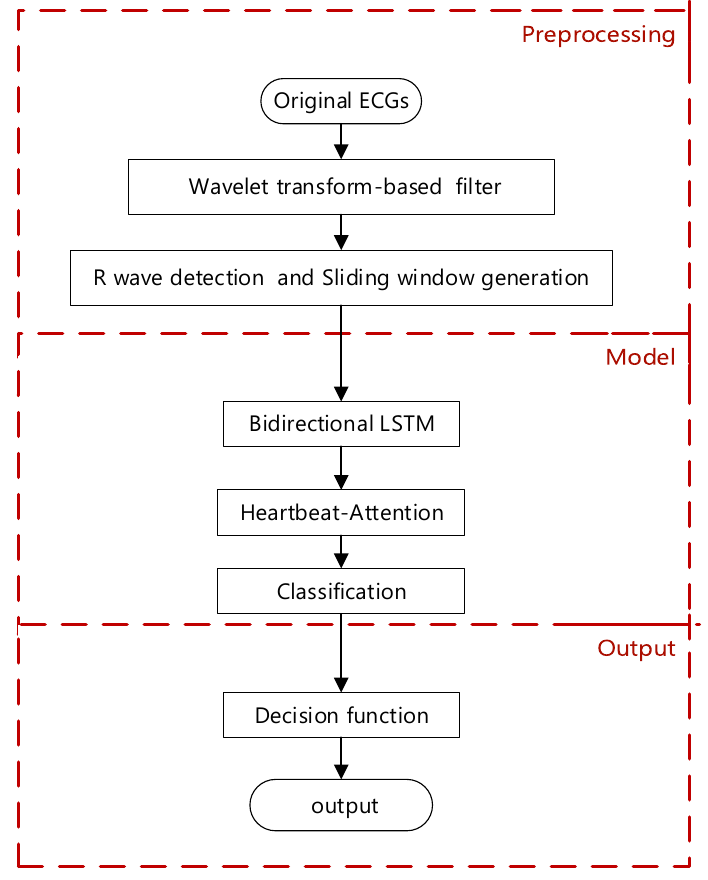
Figure 2. System Figure 2. System Framework.